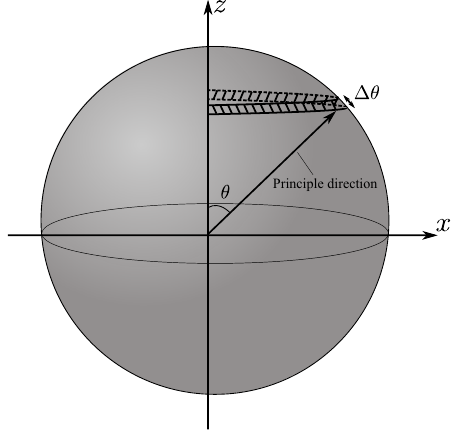
Figure 12. Principal directions on the unit